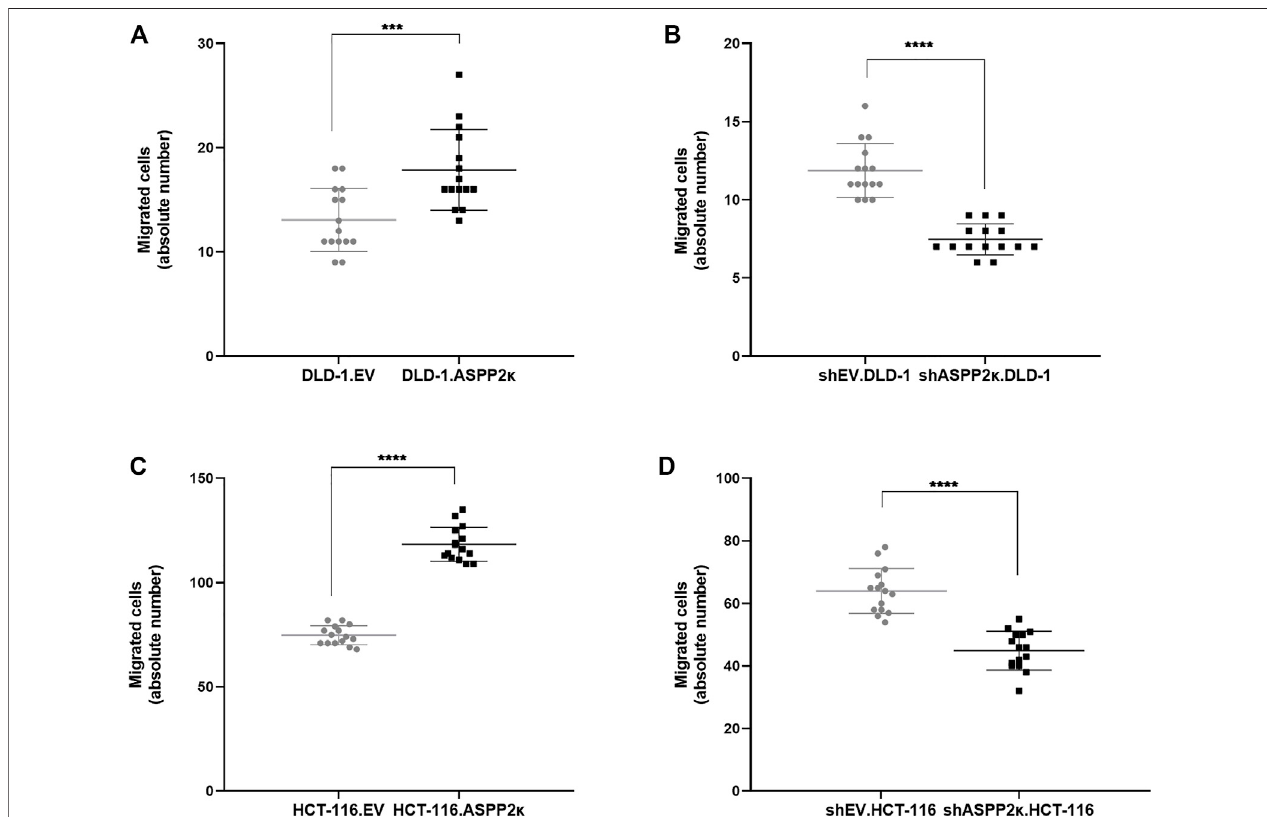
FIGURE5|(A – D) QuantitativeanalysisofmigratingcellsinatranswellmigrationassayareshownforDLD-1.ASPP2 κ (A) andHCT-116.ASPP2 κ (C) cells,resp.the ASPP2 κ -interferenced corresponding cell strains for DLD-1 (B) and HCT116 (D) . Statistical tests: unpaired t -test. **** p < 0.0001, *** p < 0.001, ** p < 0.01, * p < 0.05.